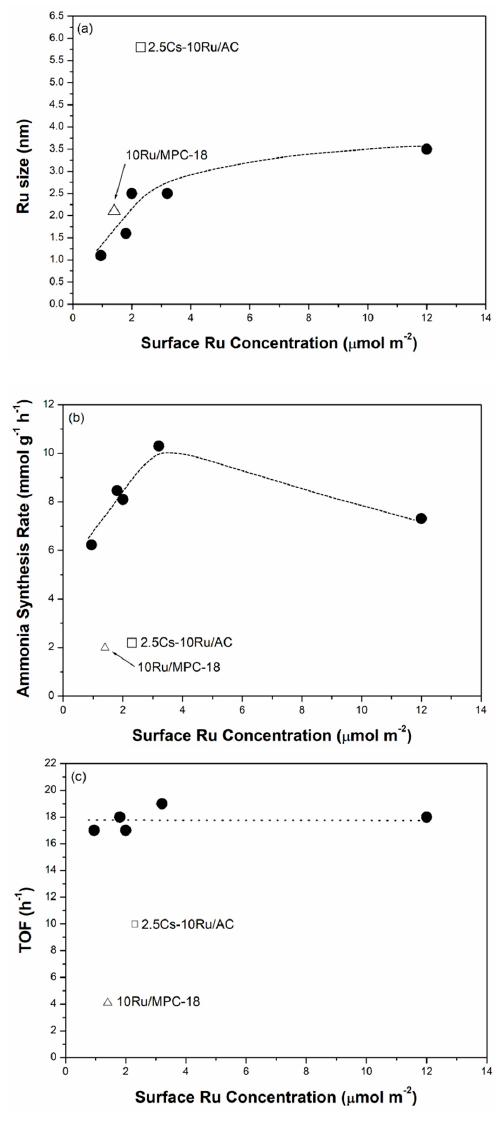
Figure 8. ( a ) The Ru size; ( b ) ammonia synthesis rate; and ( c ) TOF as a function of surface Ru concentration over the prepared Cs-Ru / MPC catalysts, in comparison to those of 10Ru / MPC-18 and 2.5Cs-10Ru / AC catalysts.